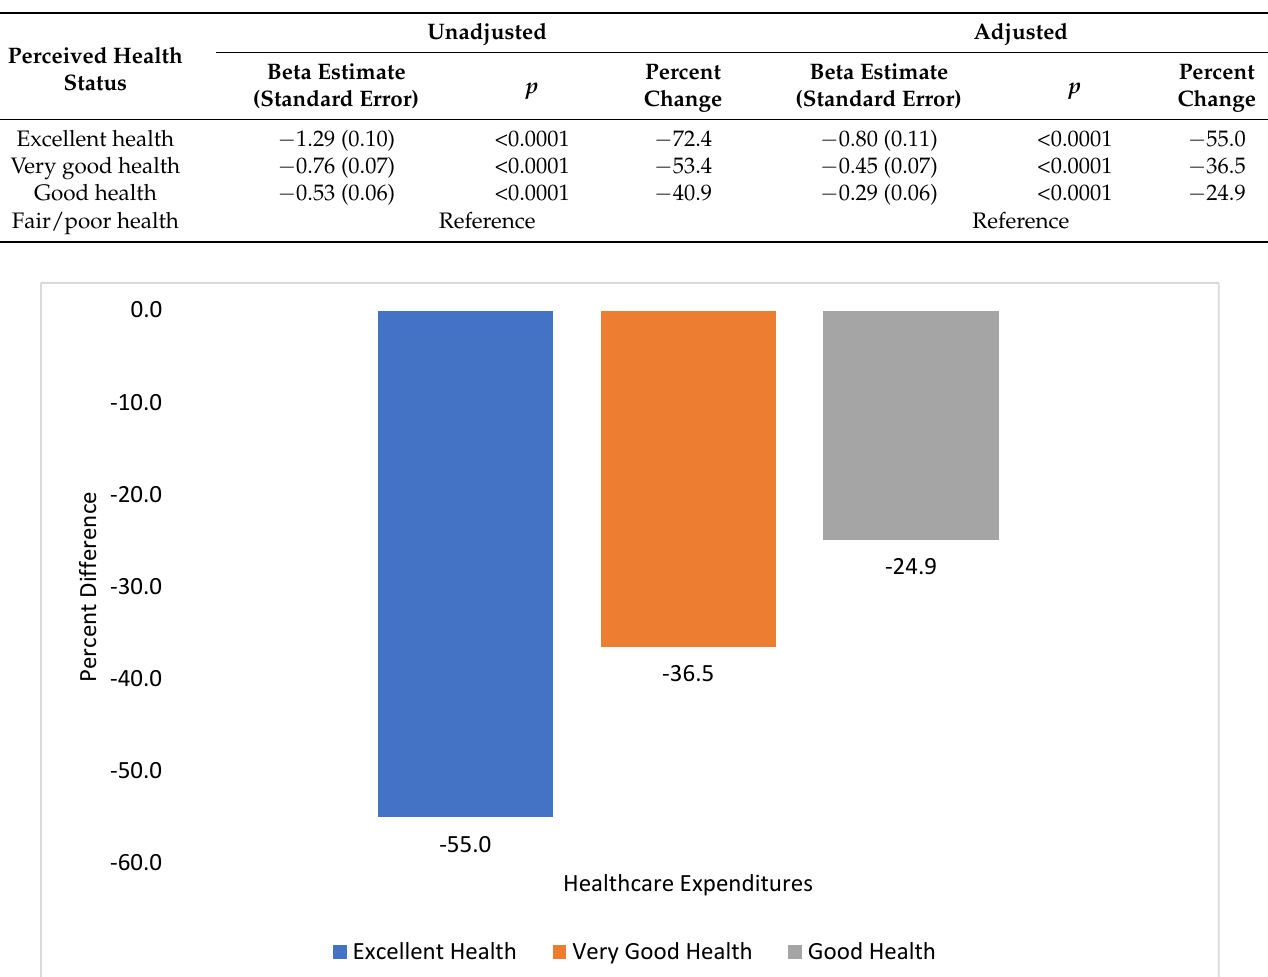
Table 2. Parameter estimates and percent changes from unadjusted and adjusted linear regression models for self-reported health status among United States older adults (age ≥ 50 years) with self-reported pain in the past four weeks, using logged annual total positive healthcare expenditures.